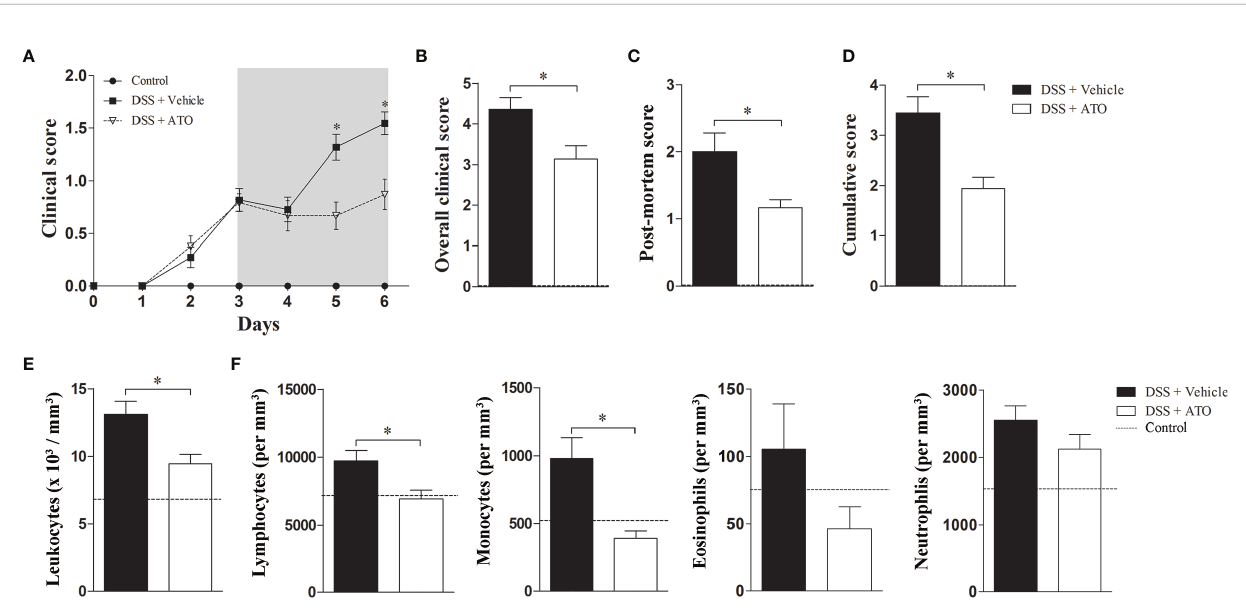
FIGURE 2 | ATO treatment improves the clinical outcome of experimental colitis. C57BL/6 WT mice were exposed to 3% (w/v) DSS in drinking water for 6 days. Mice received oral treatment once daily for three days (days 3-5) with saline (vehicle) or 10 mg/Kg/day ATO. (A) Clinical score during the disease course. The hatched area indicates the period of ATO treatment. (B) The sum of daily scores was termed as overall clinical score. (C) The macroscopic evaluation of colon after euthanasia was termed as post-mortem score. (D) The sum of clinical score on day six after DSS administration and post-mortem score was termed as cumulative score. (E, F) Total number of circulating white blood cells (leukocytes) (E) and differential leukocyte counts (F) . The dashed line indicates values from healthy control mice without colitis induction. These results are representative of 3-5 independent experiments with 5 mice per group in each experiment. Unpaired t tests or Mann- Whitney non-parametric t test were used to determine if differences attained signi fi cant response. *p < 0.05. ATO, Atorvastatin; DSS, Dextran sodium